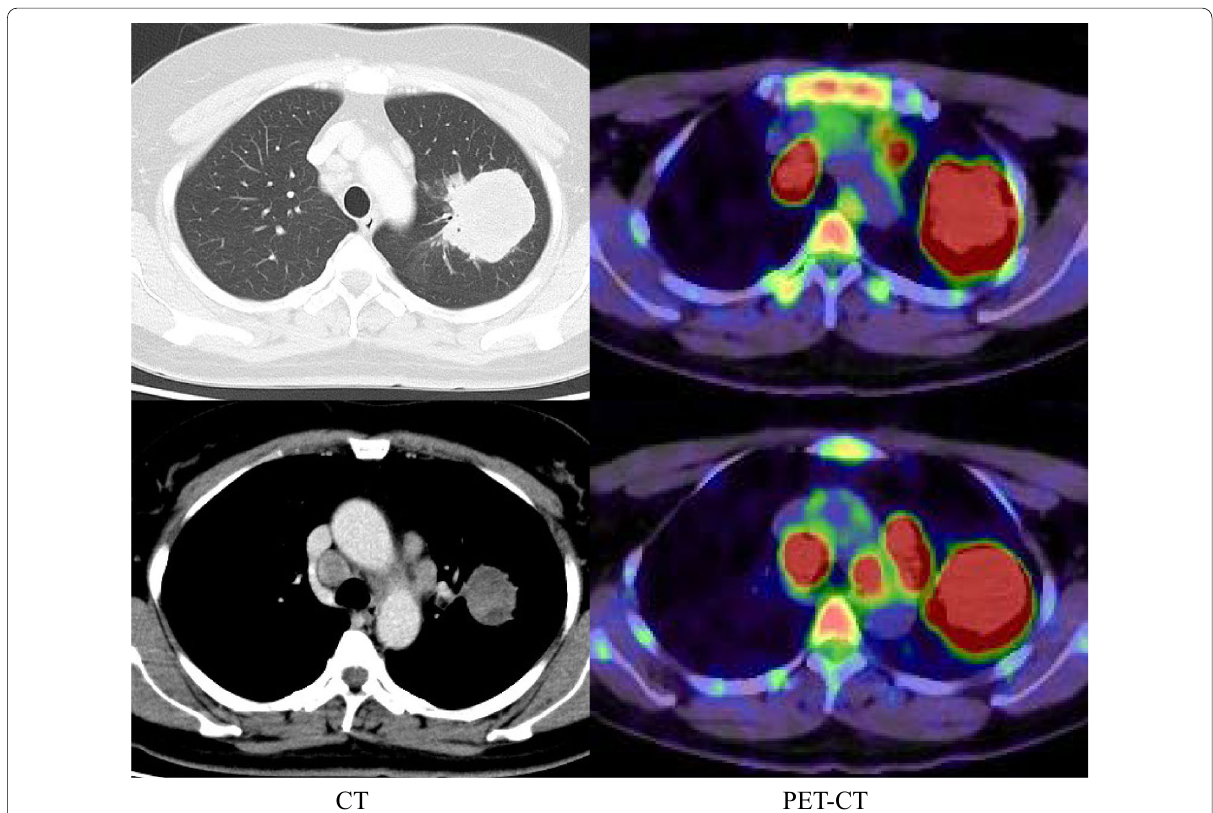
Fig. 1 Chest computed tomography (CT) and positron emission tomography (PET) suggest a primary lung tumor in the left upper lobe with mediastinal, left subclavian, and right hilar lymph node